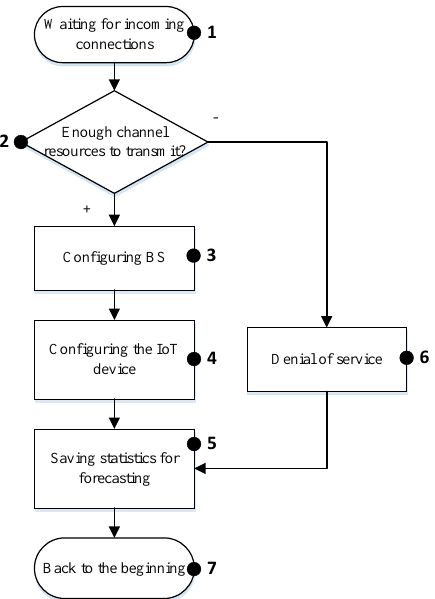
Figure 5. Block- diagram of the algorithm for managing “smart queue” for IoT classes L4.